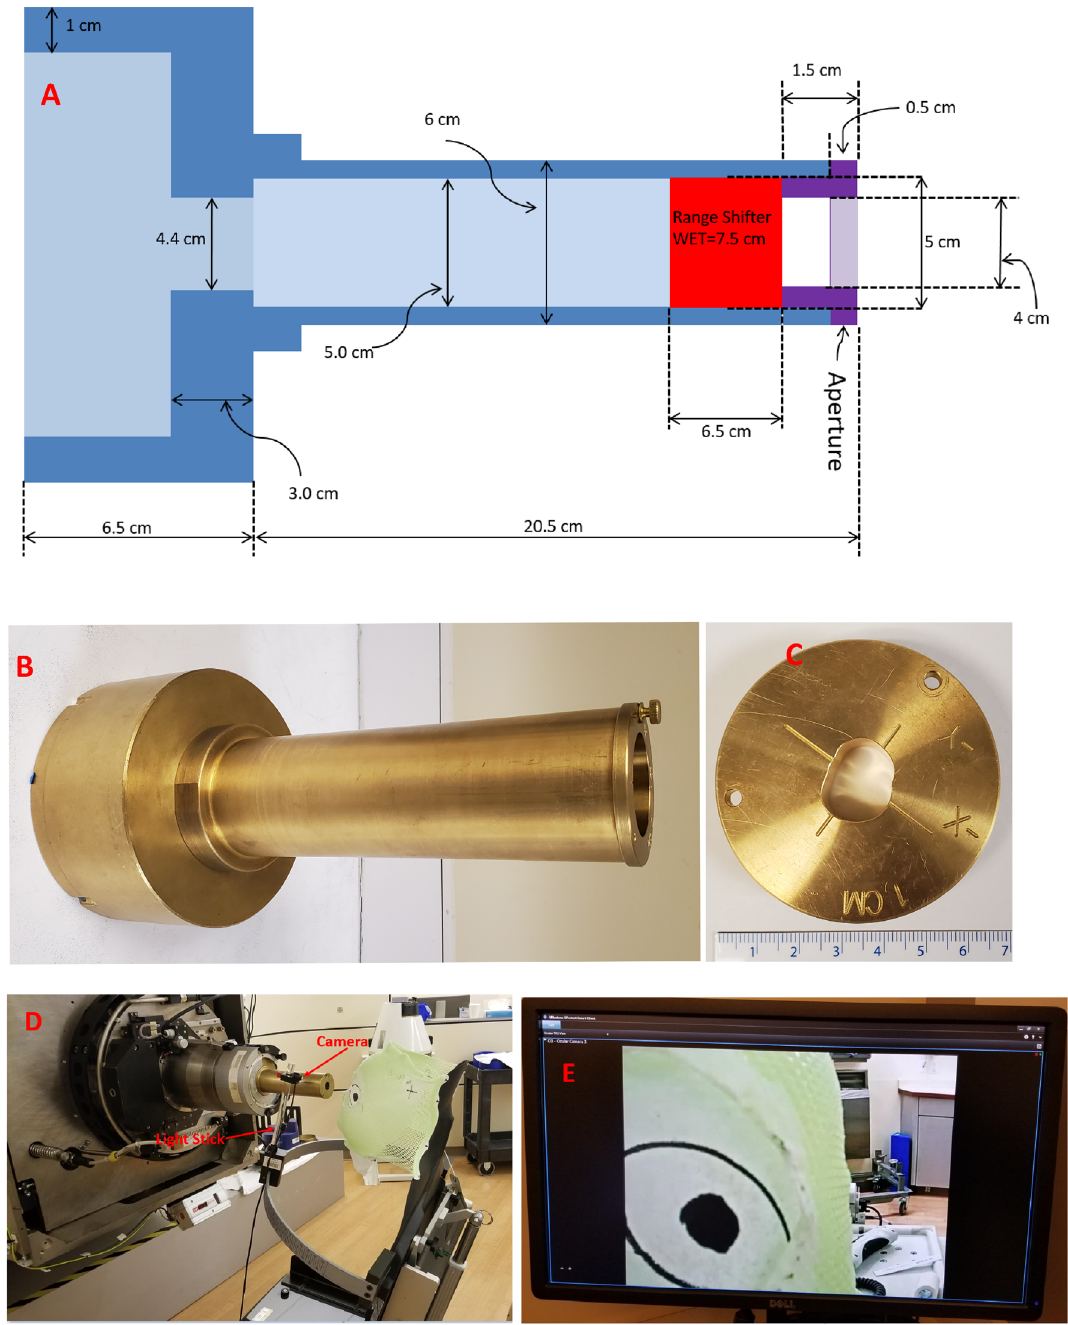
Figure 1. ( A ) Schematic of the applicator with relevant dimensions (not to scale). ( B ) An actual picture of the applicator. ( C ) A custom patient-specific aperture. ( D ) Light stick with camera mount to monitor the gaze. ( E ) Field of view of camera while monitoring gaze. The aperture is held to the applicator through a Validation measurements. Depth dose comparison. Depth dose measurements for Bragg peaks (single layer monoenergetic scanned fields) were carried out for three different circular apertures of 1.5 (F1.5), 2 (F2), and 3 (F3) cm diameter. These fields are composed of spots of single proton energy arranged in a grid-like pat- tern with an inter-spot spacing of 0.2 mm in x- and y-directions to achieve a laterally uniform dose distribution. The spot patterns for these fields were created to over-scan the respective aperture size. For each aperture size, three beams were created corresponding to a proton beam range of 2 cm, 4 cm, and 6 cm in water for a total of 9 beams. The measured depth doses were generated from individual point-by-point dose measurements along the central axis with a microdiamond detector. For comparisons, the measurement geometry for beam and set-up were simulated in the RS TPS through forward planning technique, and calculated depth doses at the central axis were exported. All RS calculations